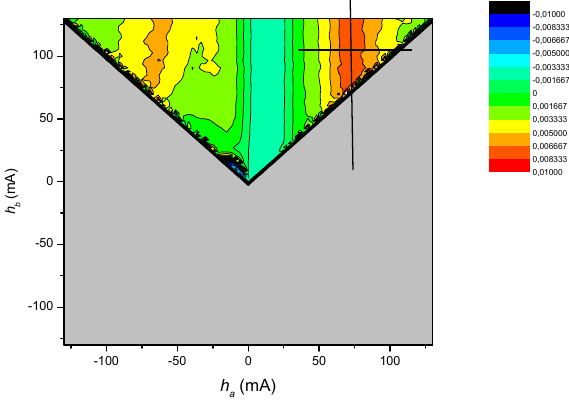
Figure 3. Map of relative sensitivity of the µ -degradation functions, µ (DBTT) ≡ µ (h a , h b ). The crossing point of the lines indicate the field coordinates of the µ i (DBTT) -degradation function used for samples of 22NiMoCr37 material.